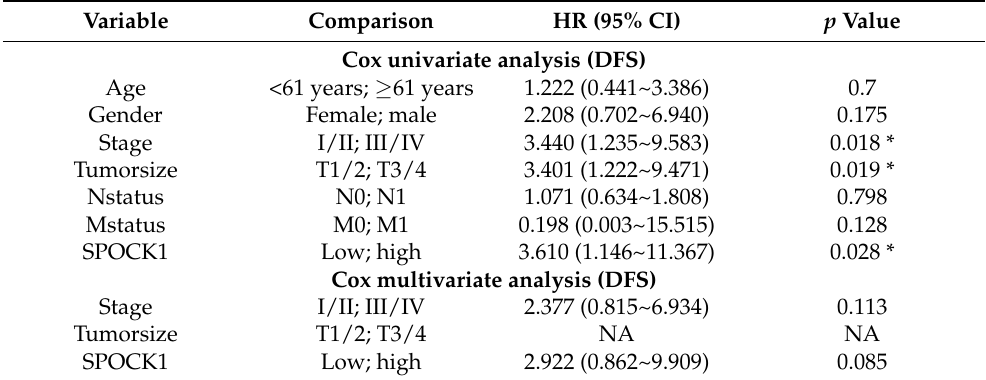
Table 2. Cox univariate and multivariate regression analyses of prognostic factors and SPOCK1 expression for disease-free survival (DFS) in 117 clear cell renal cell carcinoma (ccRCC)